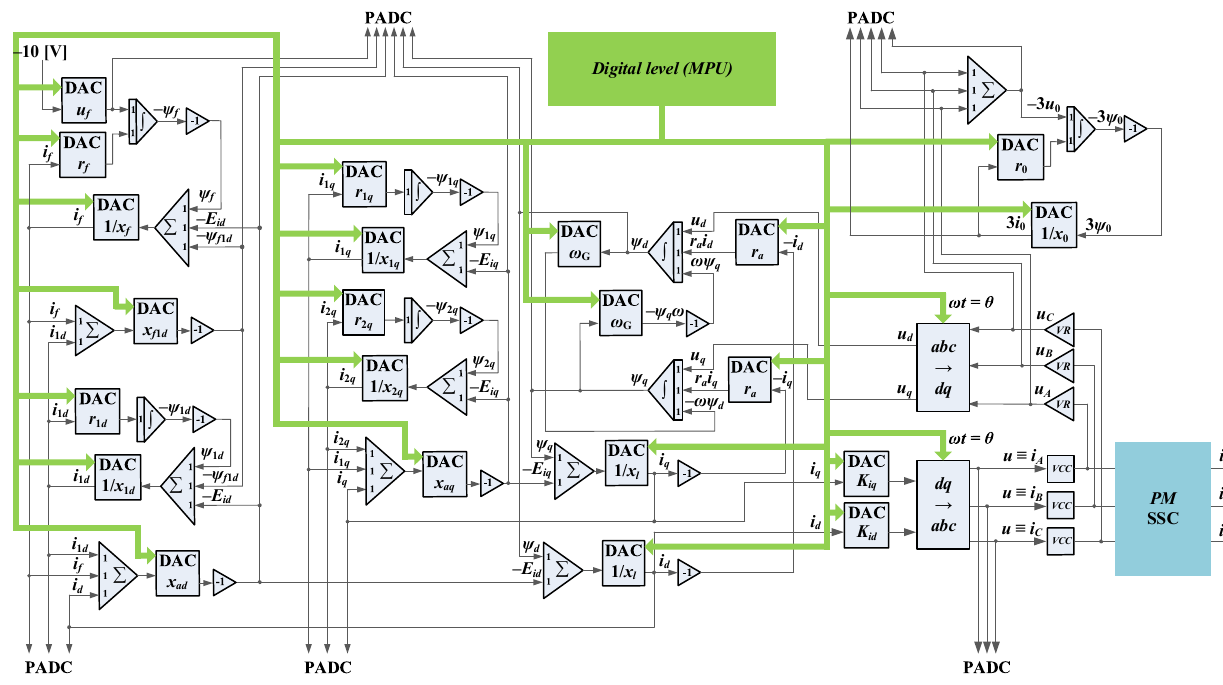
Figure 4. The functional scheme of the HCP SG.